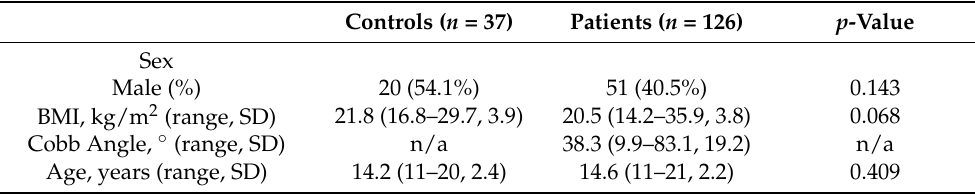
Table 1. Demographics of Control and Patient Groups.